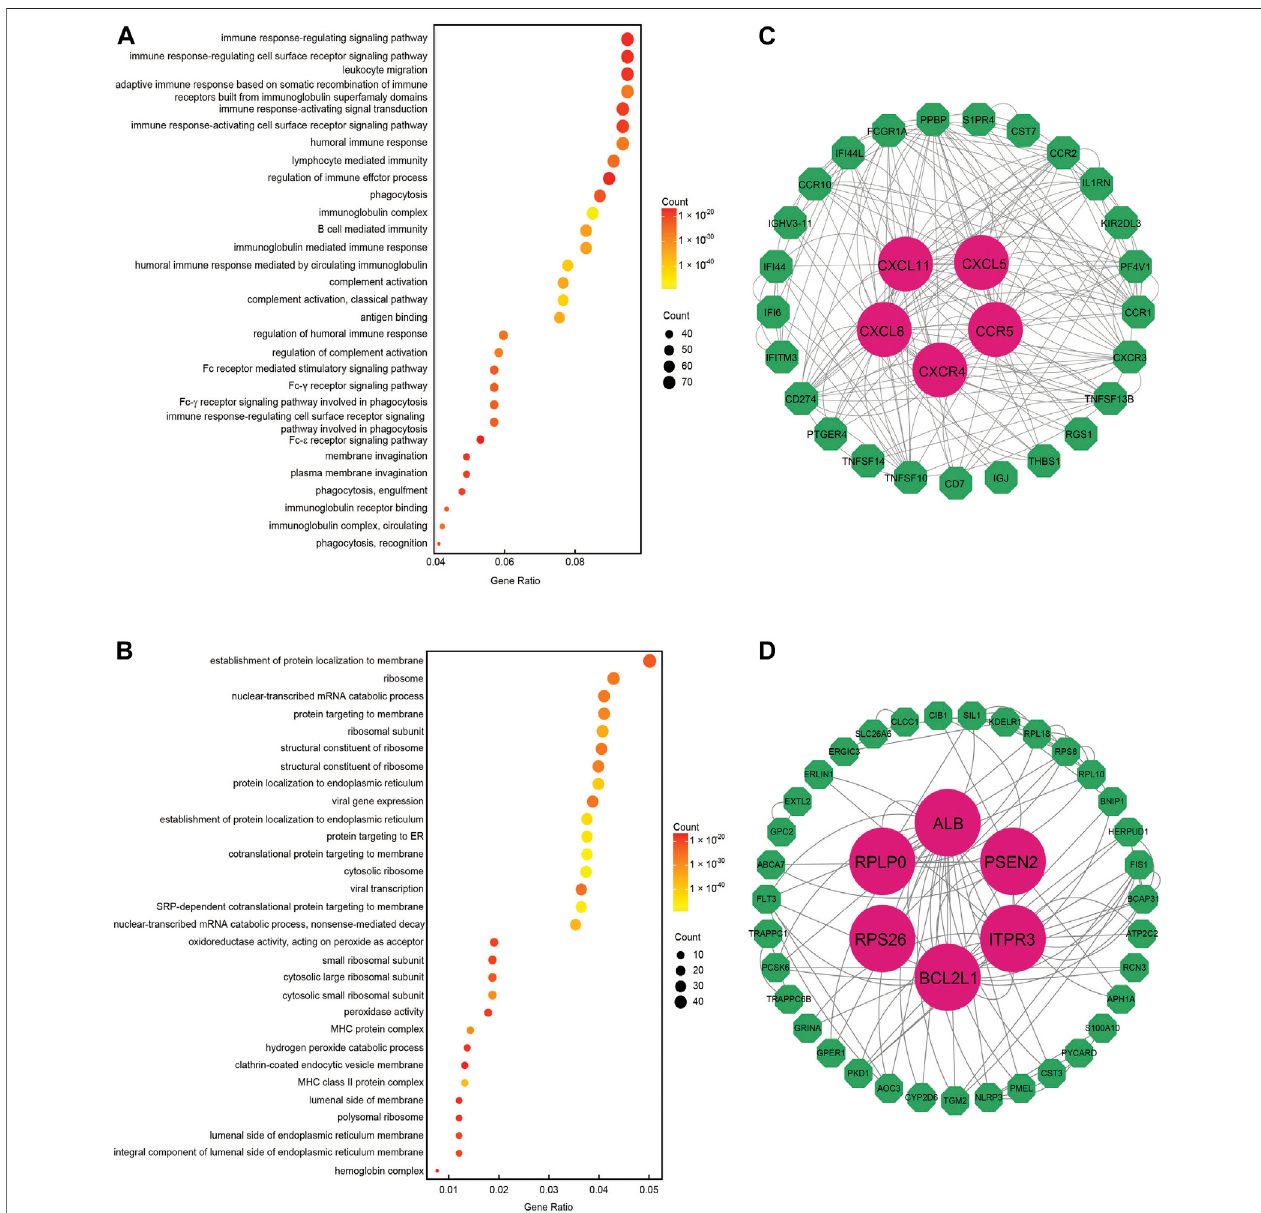
FIGURE 3 | DEGs are signi fi cantly enriched in multiple functional groups. The position of each dot represents the ratio of gene number for each GO term. The absolute number ofgene and signi fi cant level are annotated bysize and color, respectively. (A) Signi fi cant GO terms for DEGs between the metal device post-treatment group and pre-therapy. (B) Signi fi cant GO terms for DEGs between the PLLA device post-treatment group and pre-therapy. (C) Protein – protein interactions (PPIs) for the metal device therapy group. The CXCR4 gene is the core gene for the immunity response pathway. (D) PPI analysis for the PLLA device therapy group. The RPS26 gene is the core gene for the proteins targeting the endoplasmic reticulum process pathway.